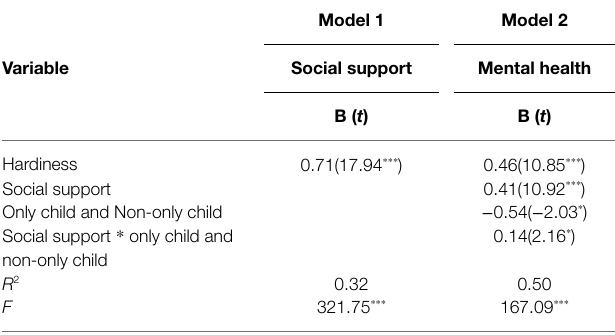
TABLE 4 | Results obtained in the testing of the moderated mediation